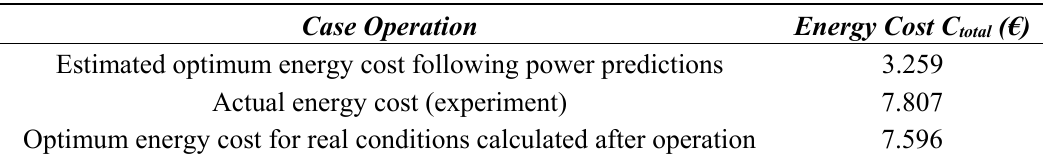
Table 3. Energy Cost Comparison for Test 2.